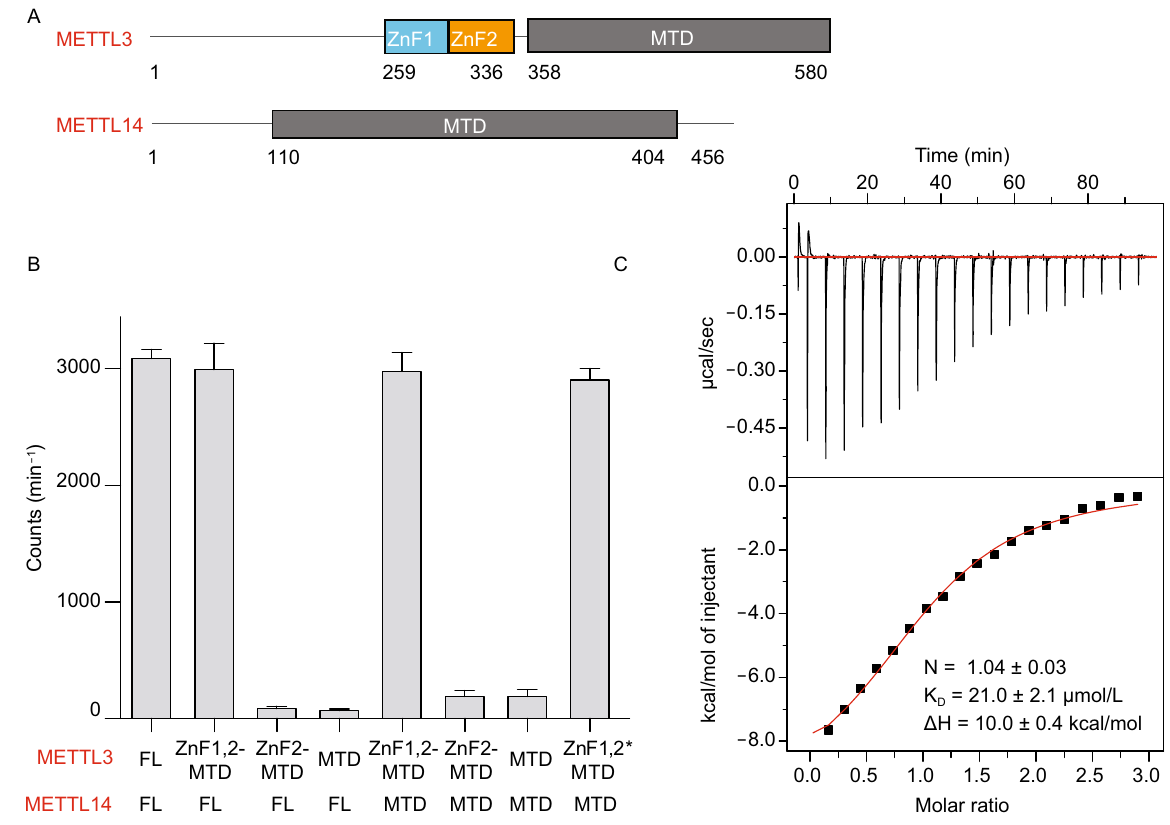
Figure 1. The ZFD is required for METTL3-METTL14 methyltransferase activity. (A) Domain architecture of METTL3 and METTL14. The structure for the MTD heterodimer has been previously determined. (B) Methyltransferase activities for various constructs of METTL3-METTL14. The ZFD of METTL3 is either recombinantly expressed (denoted with a -) or natively ligated to the MTD (denoted with a *). The average counts per minute (±SD with n = 3) are reported. (C) Isothermal calorimetry measurement